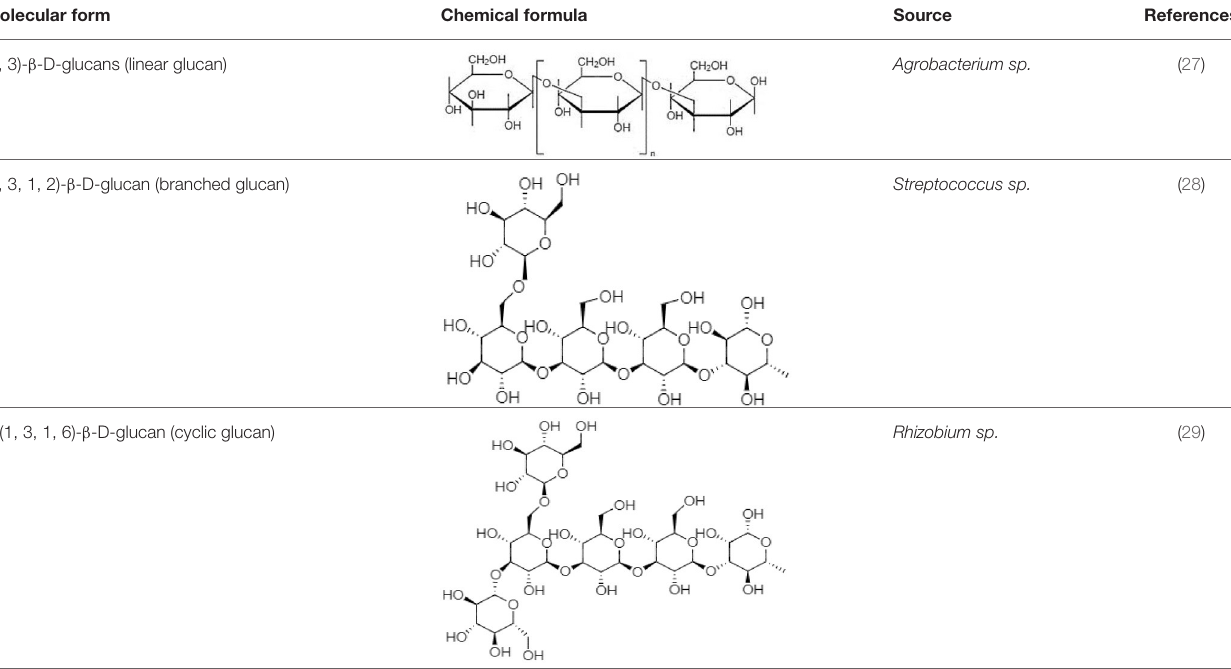
TABLE 1 | Structural forms and chemical formulas of curdlan produced by different bacterial species. Molecular form